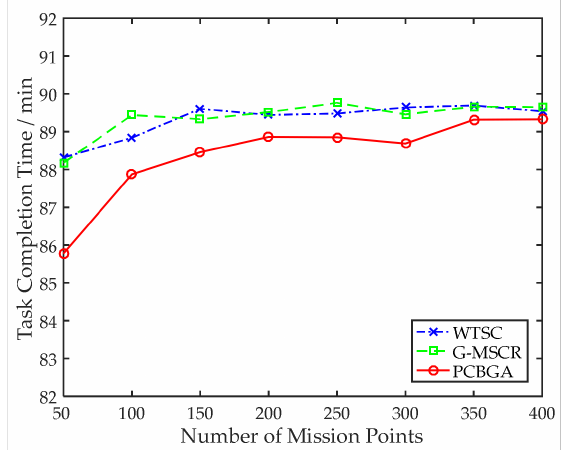
Figure 4. Comparison of the task completion time with the increase of the mission points.